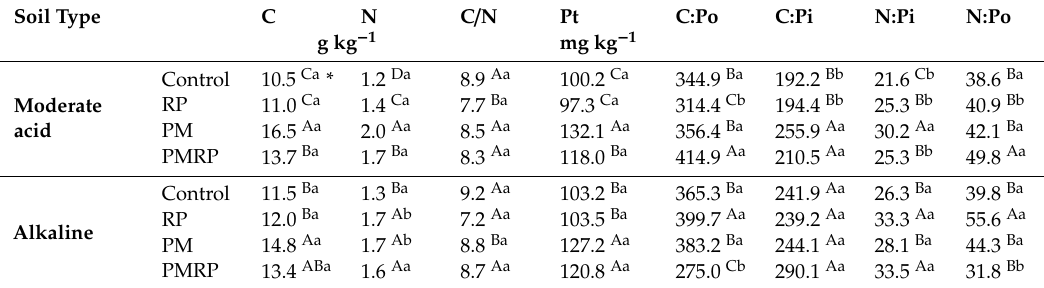
Table 3. Soil parameters in control and soil amended with poultry manure compost (PM), phosphate rock (RP), and their combination (PMRP) after 7 weeks of ryegrass